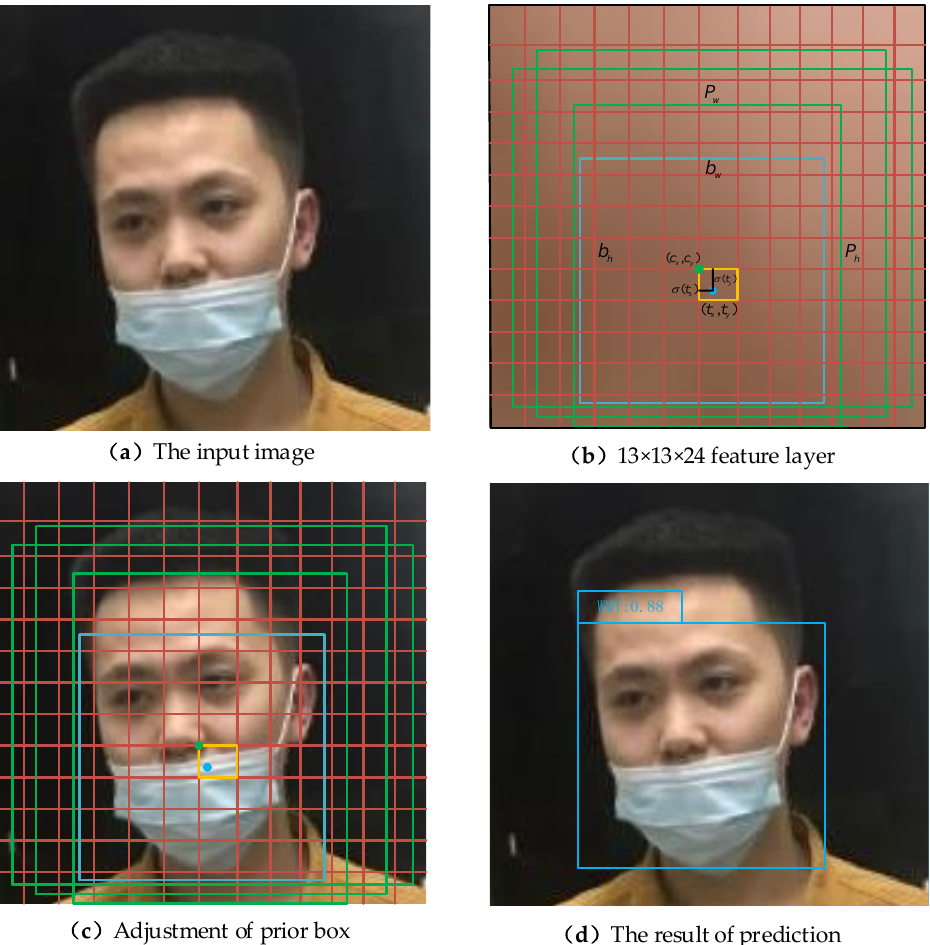
Figure 9. The process of object positioning and prediction.